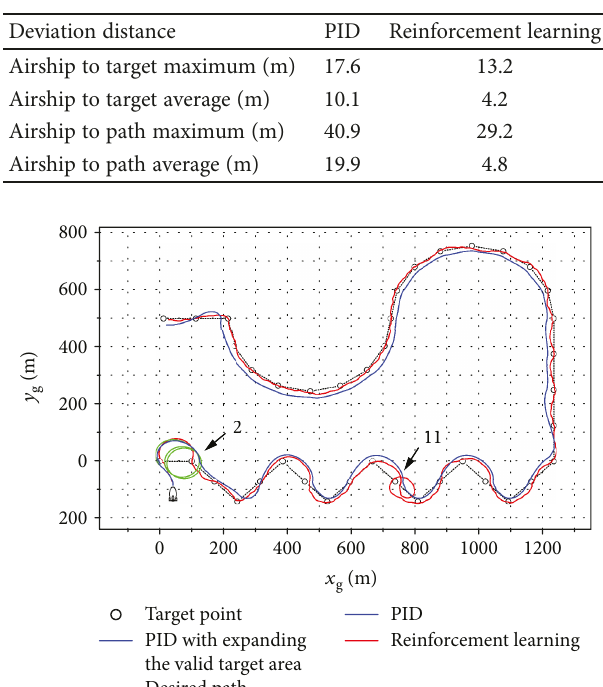
Table 2: The maximum and the average deviation distance.